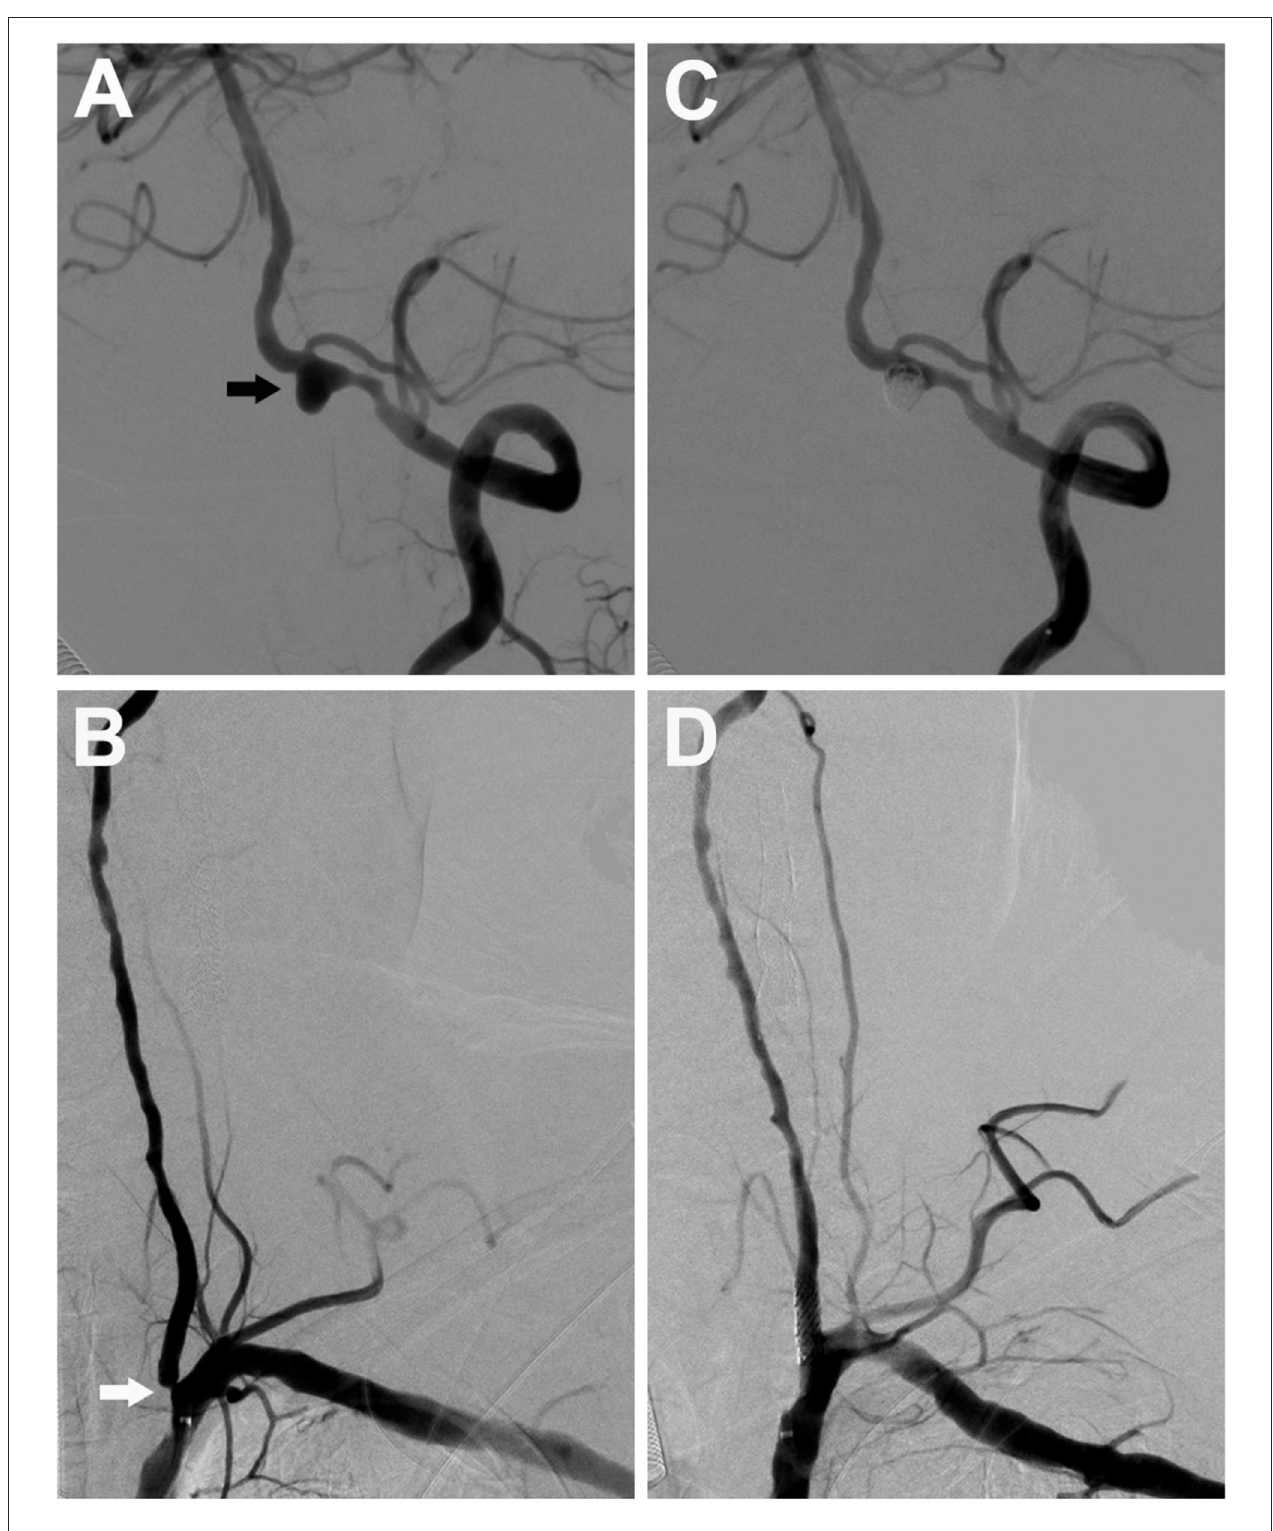
FIGURE 3 | A 75-year-old man with severe stenosis in the left vertebral artery origin (the white arrow) coexisted with an ipsilateral unruptured vertebral aneurysm (black arrow), measuring 5.5mm (A,B) . A single-stage endovascular procedure was implemented. After stent-assisted embolization of the ipsilateral tandem aneurysm, stent placement of left vertebral artery origin was applied. After single-stage treatment, the left subclavian artery angiogram showed complete aneurysm exclusion (C) and satisfactory vertebral revascularization (D) .